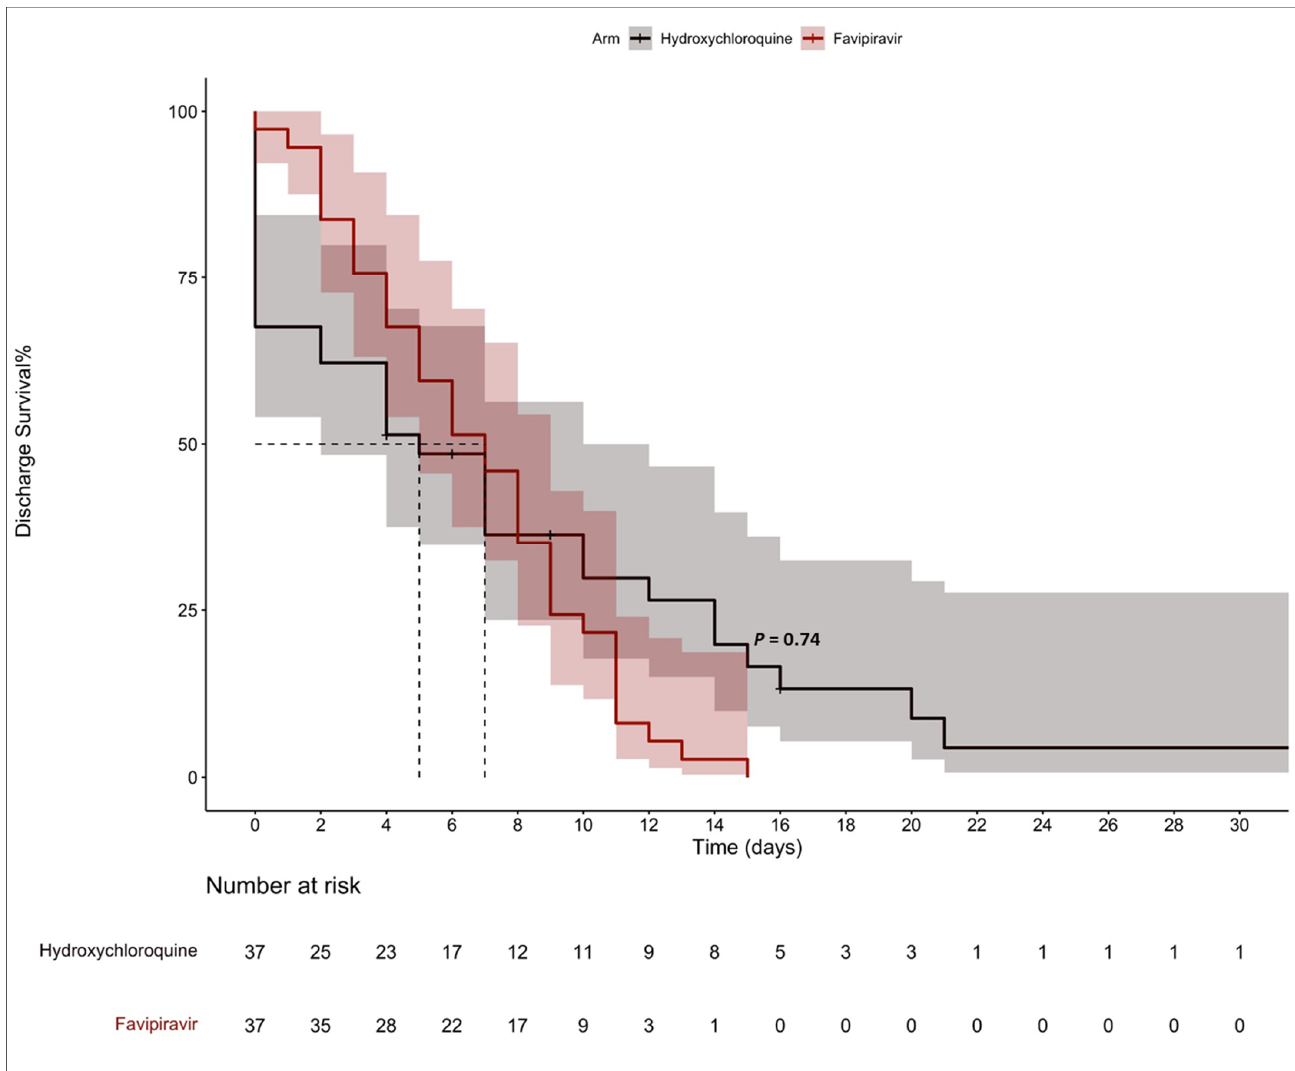
Figure 2. Kaplan–Meier for the median time to discharge in the matched sample. Dashed lines for the median. Decrease in survival indicates the discharge events. Table 2. Clinical outcomes in the matched sample.